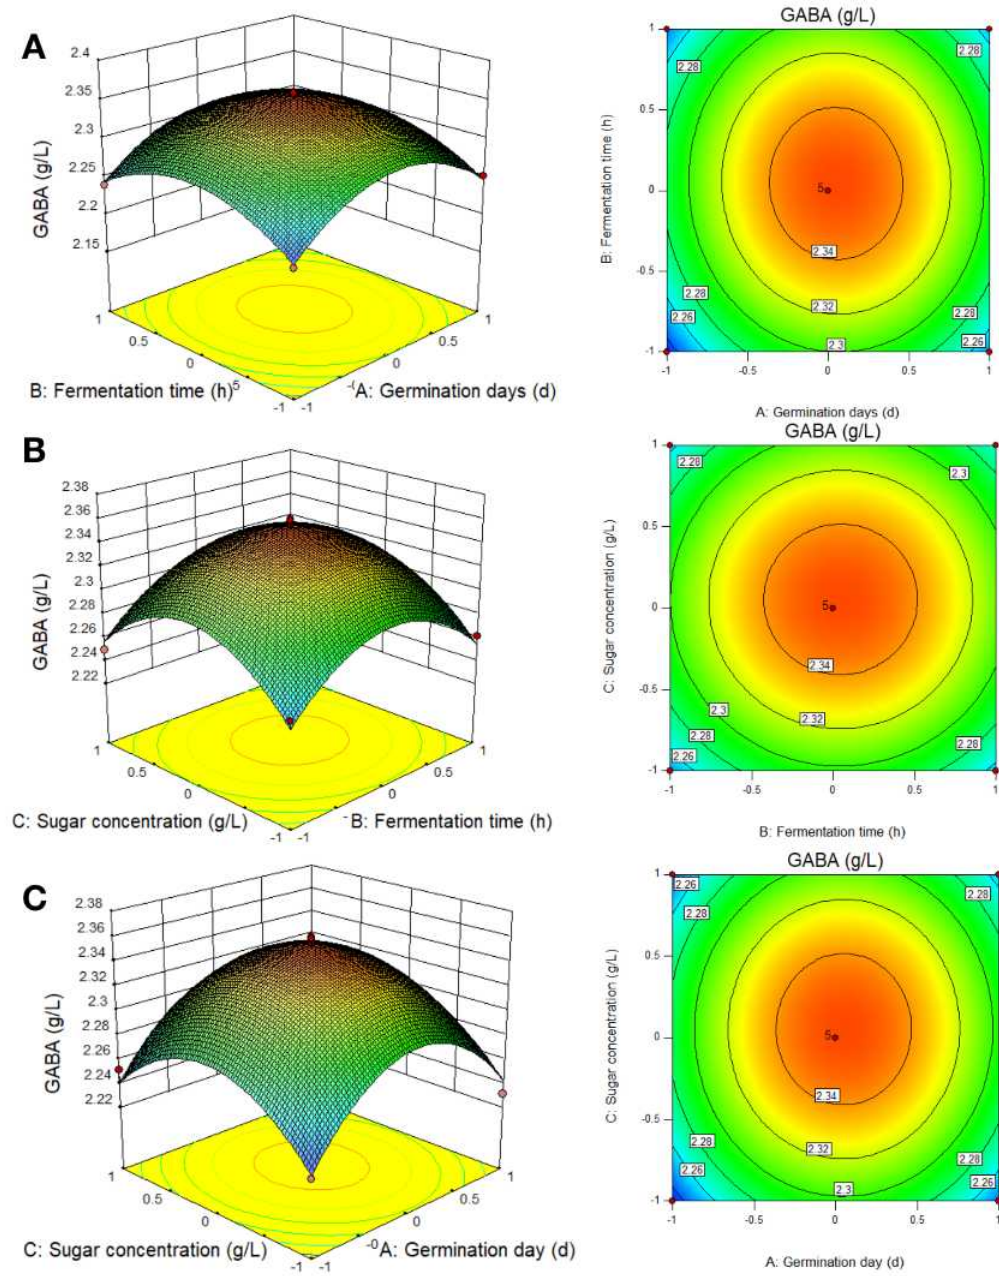
Figure 3. Three ‐ dimensional surface plots show the effects of different variables on GABA produc ‐ Figure 3. Three-dimensional surface plots show the effects of different variables on GABA tion. ( A ) Effect of germination days and fermentation time; ( B ) Effect of fermentation time and sugar concentration; ( C ) Effect of sugar concentration and germination day.